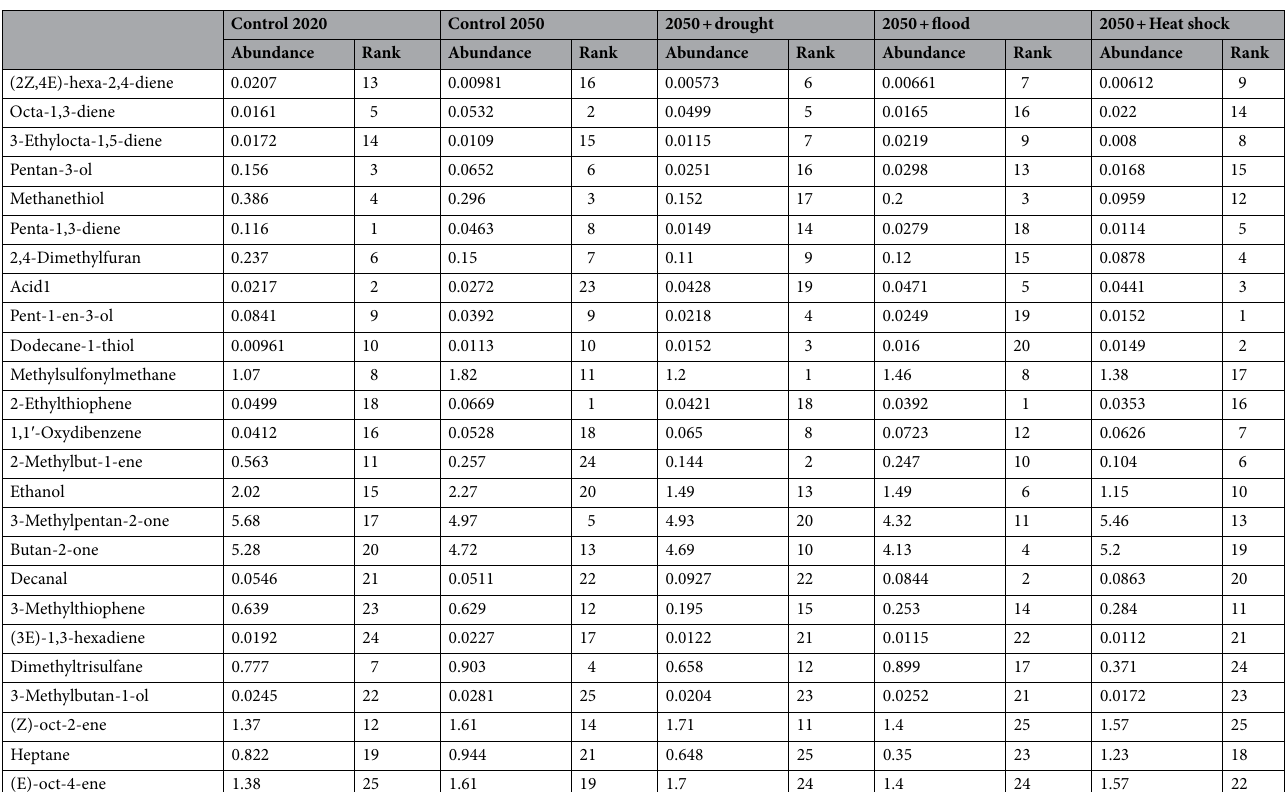
Table 6. Top 25 compounds most important for random forest classification of climate scenario, ranked in order of their importance in discriminating each climate scenario at 24 h post incubation (see Table S2 for raw importance scores). Based on 100,000 trees. Abundance is the mean relative abundance of the compound in each growth condition (based on total area normalisation). Compounds are shown in order of